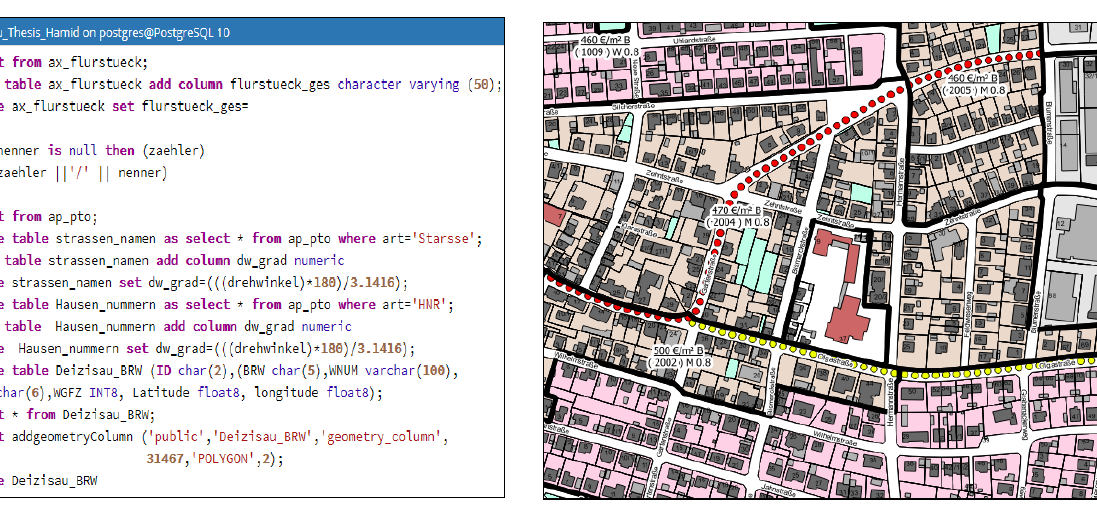
Figure 3: SQL code for layer preparation in database